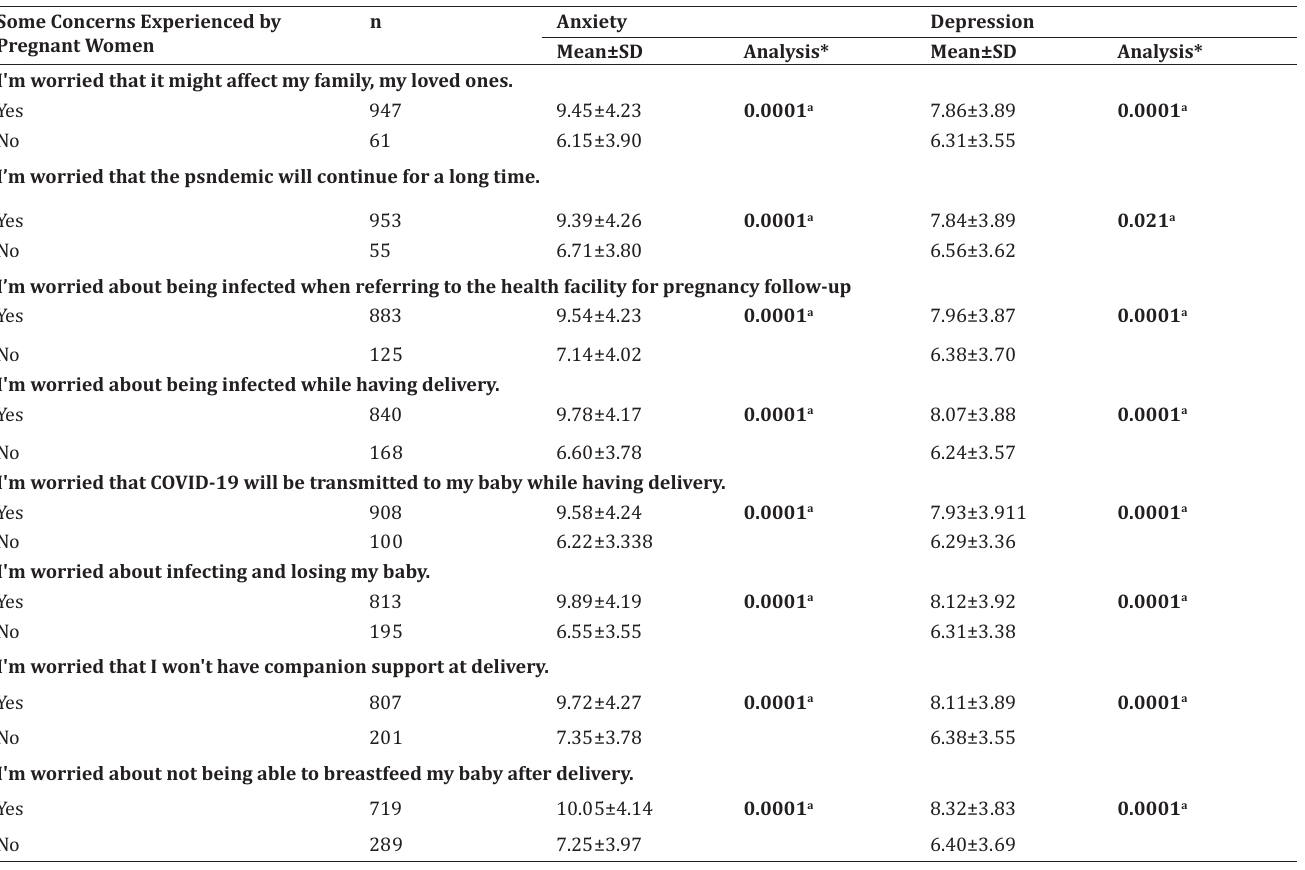
Distribution of anxiety and depression scores according to pregnancy-related